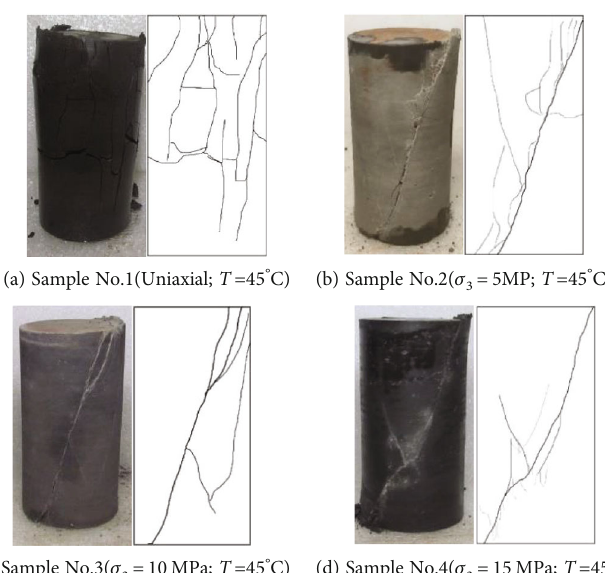
Figure 8: Before and after T-M coupled test and crack distribution.